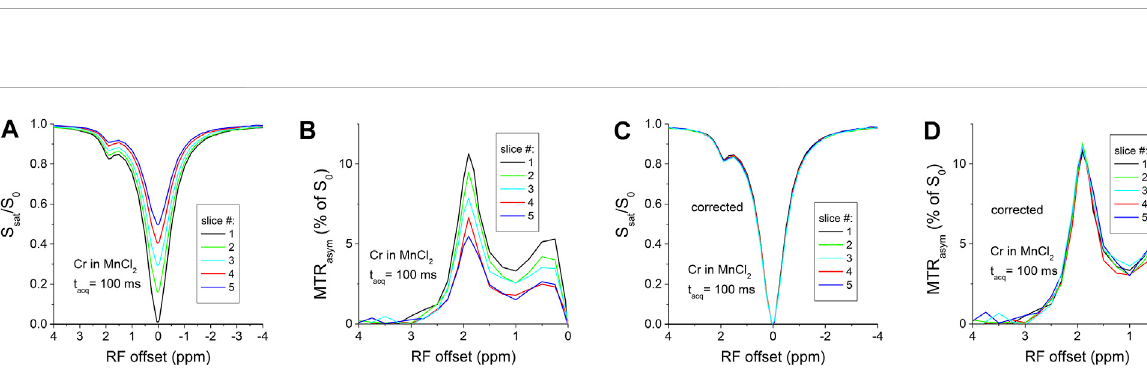
Multi-slice CEST Z-spectraofcreatine inPBS.The rawZ-spectrashow small difference ofafewpercent among the fi veslices witht acq =50 ms (A) , and the difference becomes larger with a longer t (B) . The T acq of 100 ms 1 -relaxation effects can be clearly seen near the water frequency in the Insets. (C,D) These differences can be satisfactorily corrected by Eq. 3, leading to overlapping Z-spectra for the fi ve slices.